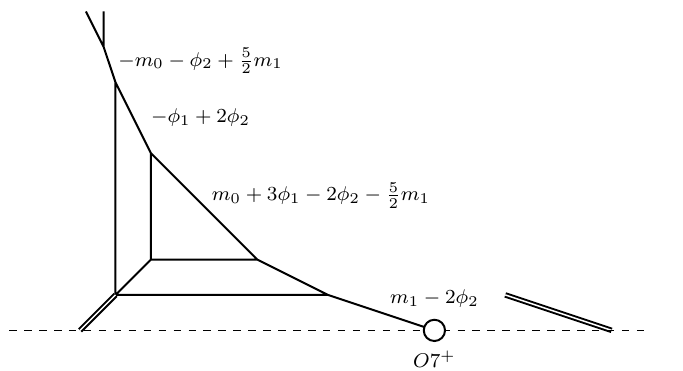
+ 1 Sym , after flopping the edges with lengths m 0 + φ 1 − − 1 / 2 m 1 2